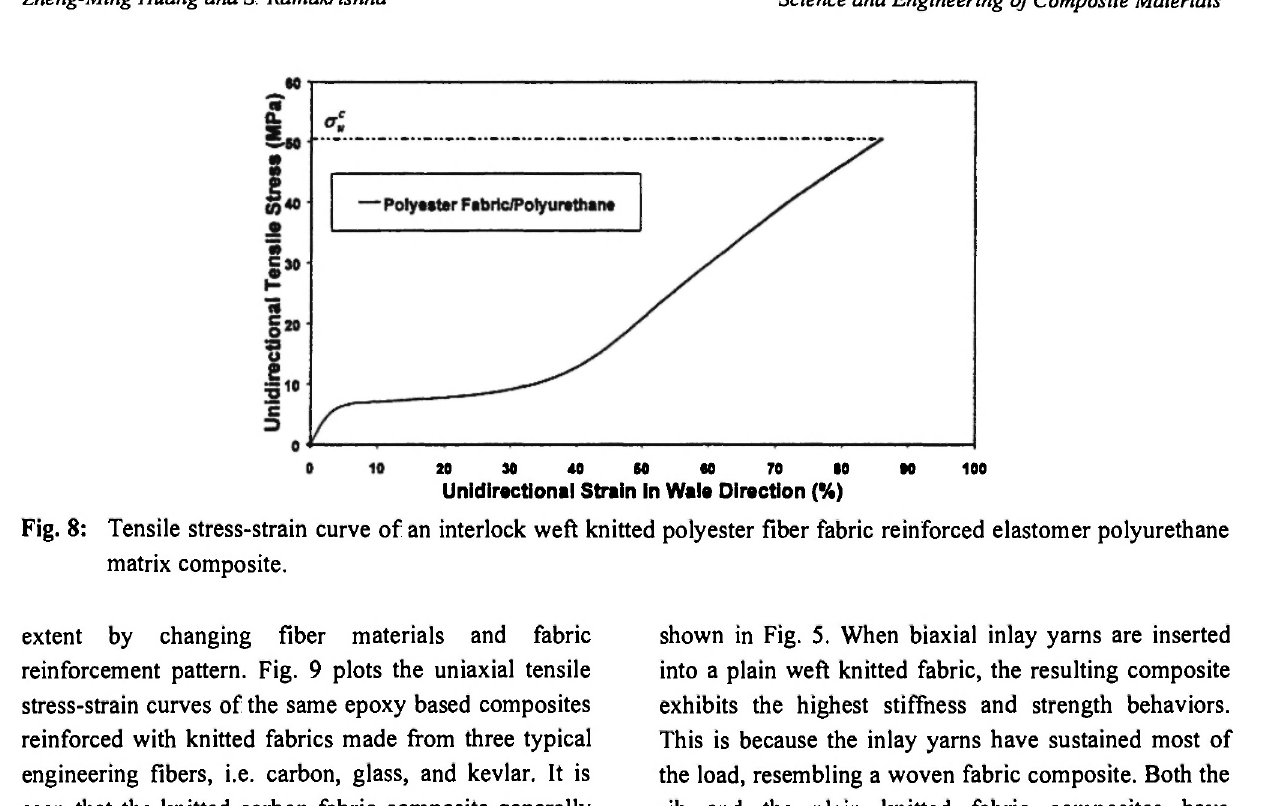
Fig. 8: Tensile stress-strain curve of an interlock weft knitted polyester fiber fabric reinforced elastomer polyurethane matrix composite.